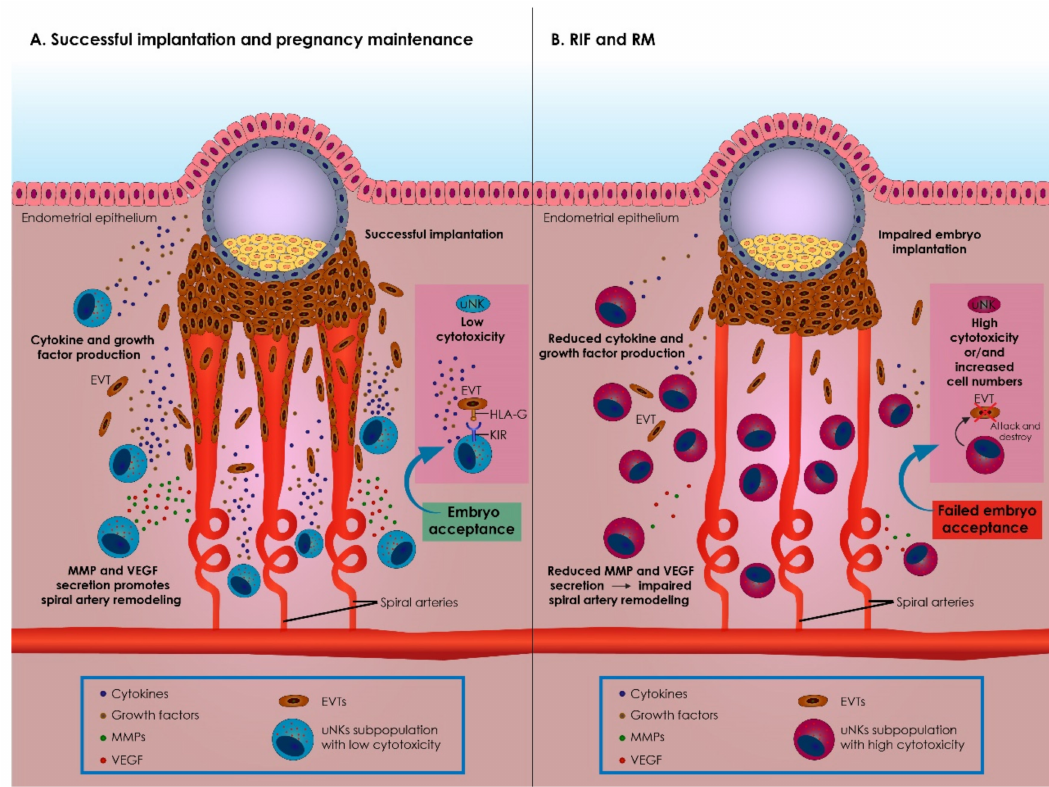
Figure 1. A summary of the role of uterine natural killer (uNK) cells on the events entailed in successful embryo implantation and maintenance of a pregnancy, as well as on the pathophysiological mechanisms involved on recurrent implantation failure (RIF) and recurrent miscarriage (RM), respectively. ( A ) Successful implantation and pregnancy maintenance. In physiological conditions, uNK subpopulations presenting with low cytotoxicity constitute the predominant leucocyte population in the decidua. During implantation, uNK cells interact with the extravillous trophoblast cells (EVTs), acknowledging the human leukocyte antigens G (HLA-G) via their killer cell immunoglobulin-like (KIR) receptors. These interactions are essential for several reasons. To begin with, these interactions lead to maternal immunological accommodation of the semi-allogeneic fetus, establishing an interface between the mother and the fetus. Additionally, these interactions trigger uNK cells to secrete several cytokines and growth hormones, promoting trophoblast invasion. Following their triggering, uNK cells secrete several matrix metalloproteinases (MMPs) and angiogenic factors, such as vascular endothelial growth factor (VEGF), regulating remodeling of the spiral arteries. Successful implementation of these events is essential for achieving implantation and pregnancy maintenance. In summary, uNK cells constitute master regulators of the events entailed during embryo immunological acceptance during EVTs invasion as well as during spiral arteries’ remodeling. ( B ) Events entailed in implantation failure leading to inadequate pregnancy maintenance in RIF and RM. When uNK cells present with increased numbers and/or with an abnormally increased cytotoxic phenotype, all the events entailed in normal embryo implantation are dysregulated. Due to their increased cytotoxic phenotype, this abnormal uNK cells subpopulation fails to appropriately interact with EVT cells, and instead they attack and destroy EVTs. Furthermore, secretion of growth hormones and cytokines by abnormal uNK cells is compromised, reducing EVTs invasion into the decidua. Ultimately, abnormal uNK cells fail to promote spiral arteries remodeling. These events lead to implantation failure or to impaired pregnancy maintenance, eventually resulting in miscarriage. RIF: recurrent implantation failure; RM: recurrent miscarriage; uNK: uterine natural killer cells; EVT: extravillous trophoblast; HLA-G: human leukocyte antigen G; KIR: killer cell immunoglobulin-like receptor; MMPs: matrix metalloproteinases; VEGF: vascular endothelial growth